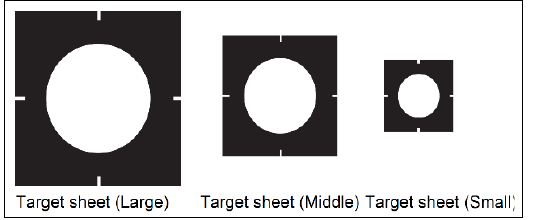
Figure 22. Three types of target sheet manufactured by Topcon